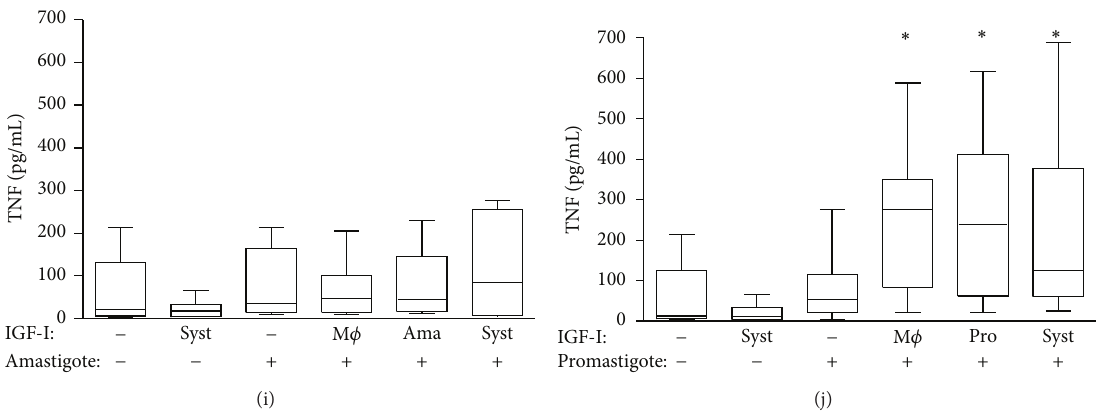
Figure 2: Effect of IGF-I on cytokine production by BALB/c peritoneal macrophages infected with amastigotes or promastigotes of L. (L.) amazonensis. Cytokine levels were determined in the culture supernatant by ELISA: IFN- 𝛾 : (a) and (b); IL1- 𝛽 : (c) and (d); IL-6: (e) and (f); TGF- 𝛽 : (g) and (h); TNF: (i) and (j). Boxes represent the median values and the 25th and 75th percentiles (3 experiments, 𝑛 = 6 ). M 𝜙 = macrophage, ama = amastigote, pro = promastigote and Syst = System. ∗ 𝑃 < 0.05 compared with promastigote-infected macrophage without IGF-I stimulation. (Kruskal-Wallis test with the Student Newman-Keuls contrast